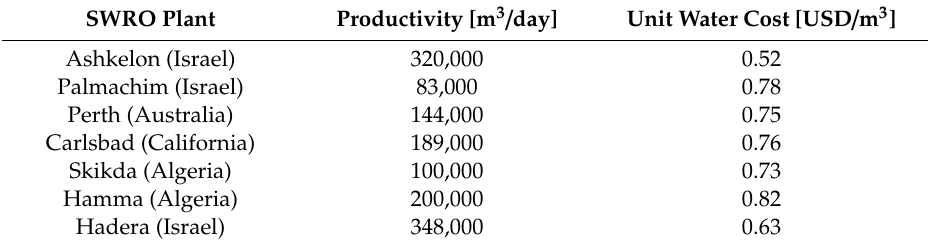
Table 2. Productivity and unit water cost of some large SWRO plants [19]. SWRO